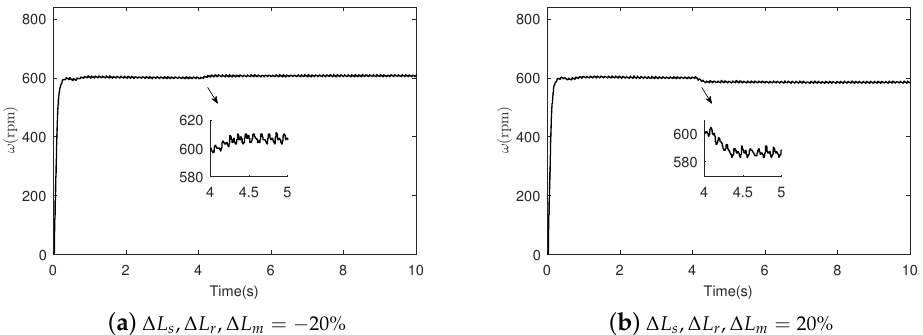
Figure 12. Speed response curves when the inductance value changes suddenly.